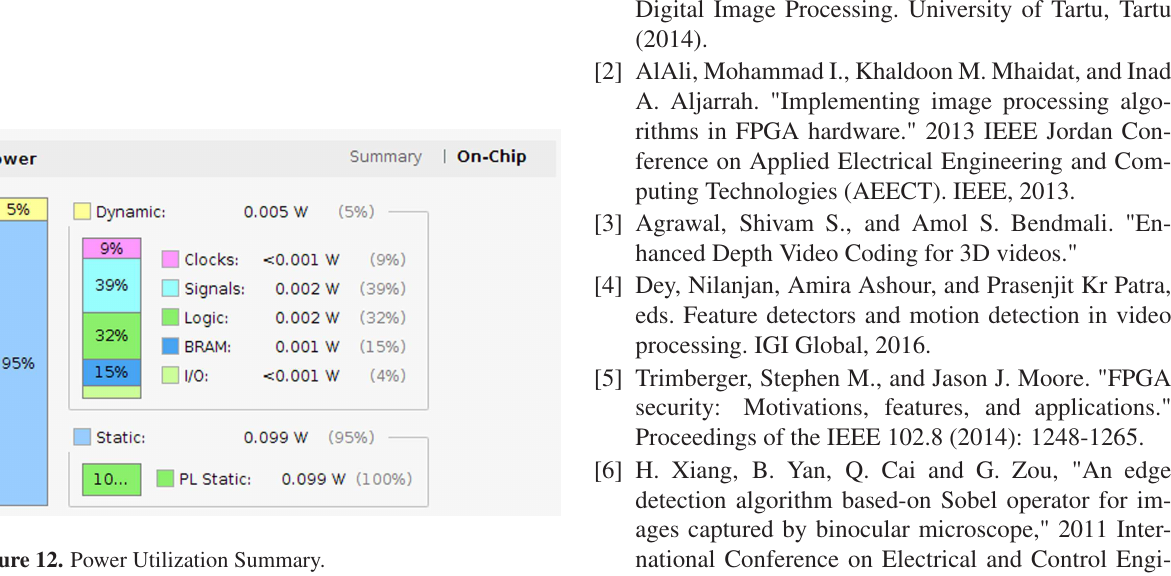
Figure 11. Result of Sobel Operator on VGA.